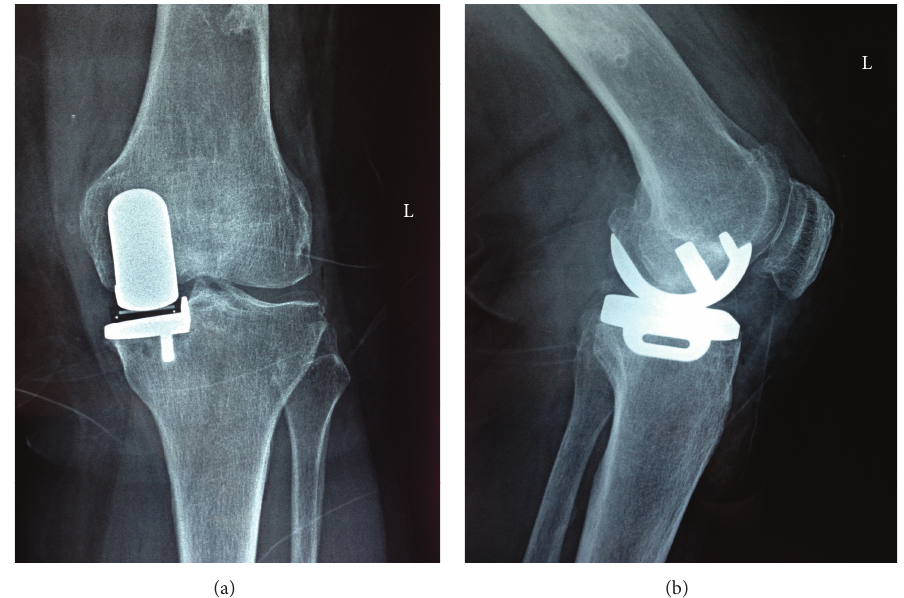
Figure 2: (a) A 51-year-old female patient that underwent uncemented Oxford UKA, anterior-posterior view. (b) Lateral view.